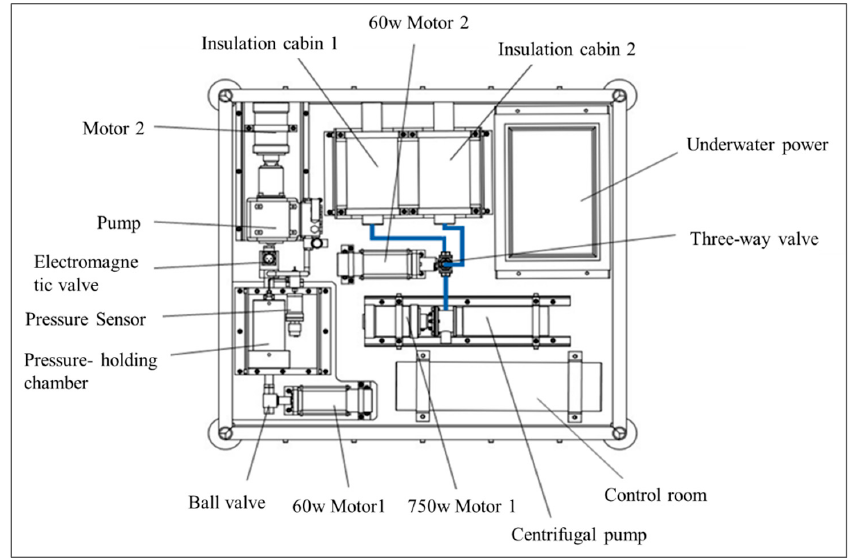
Figure 2. The main body of the multi-link visual control large-caliber trawl system.